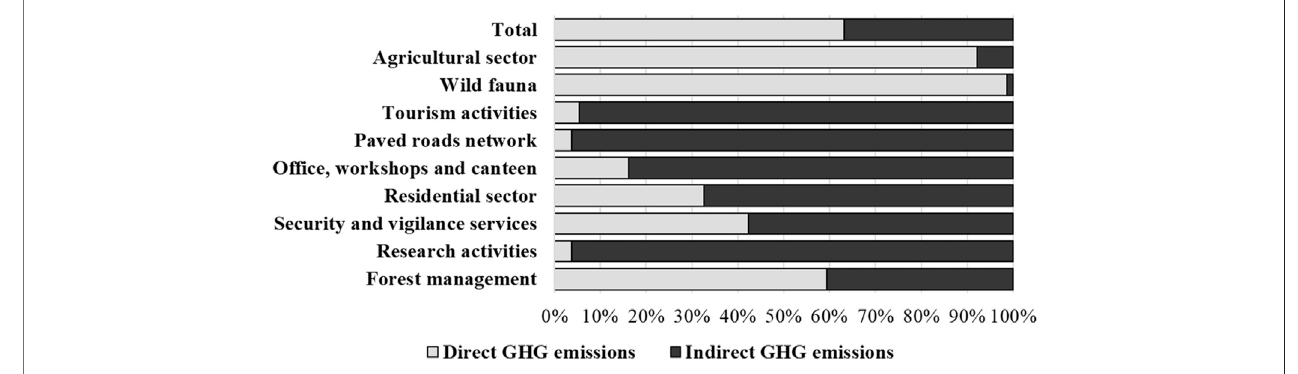
FIGURE 4 | Breakdown of the direct and indirect GHG emissions on the total Reserve ’ carbon footprint and within each sector considered.